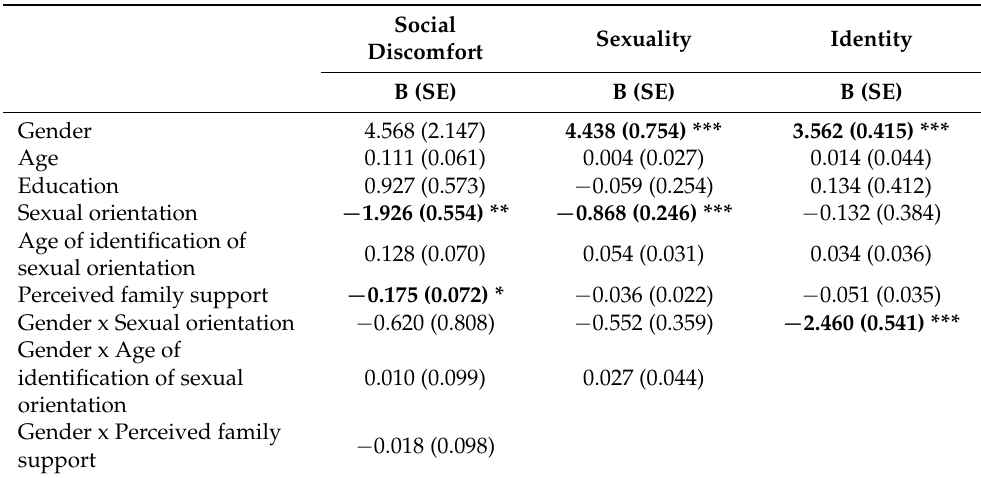
Table 3. Moderating effects of gender on the associations of internalized sexual stigma with related factors: Multivariate linear regression